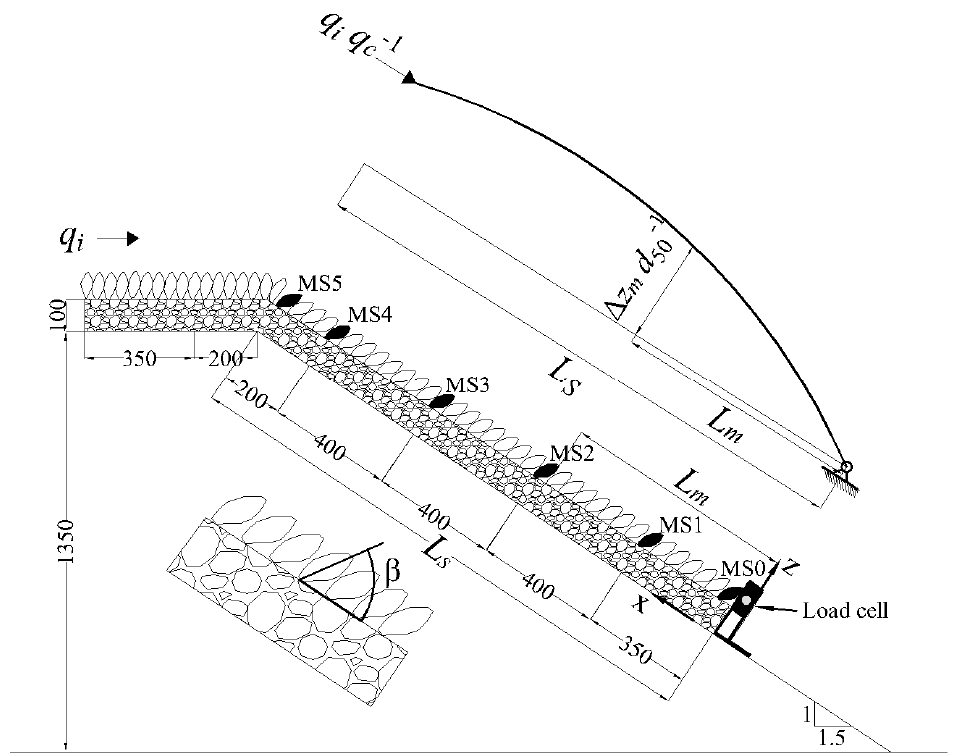
Figure 1. Representation of the experimental set-up with positions of marked riprap stones (MS 0–5) and lengths, adapted from Ravindra et al. [20].